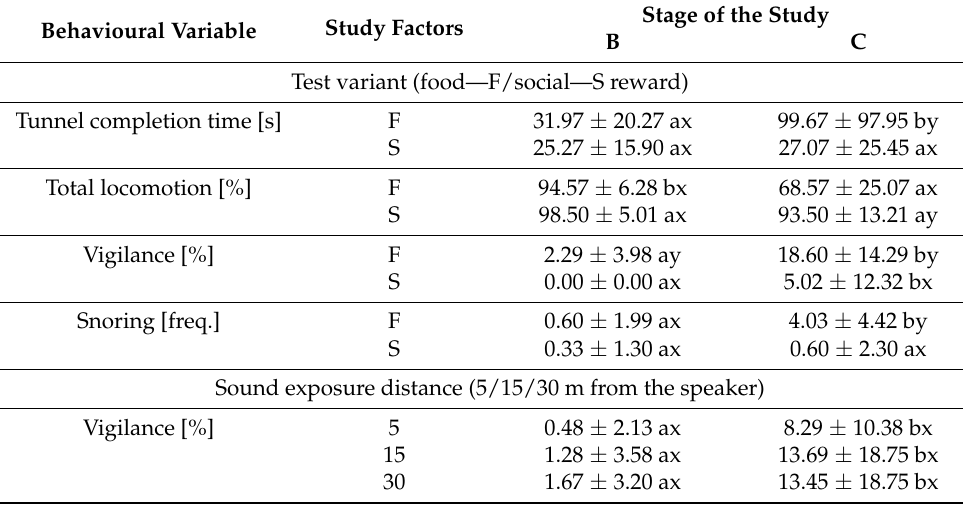
Table 3. Differences in horses’ behaviour (means ± SD) in two stages of the sound tunnel test (B—control trial, without the sound and C—experimental trial, with the sound), depending on the test variant and sound exposure distance. Behavioural Variable Study Factors